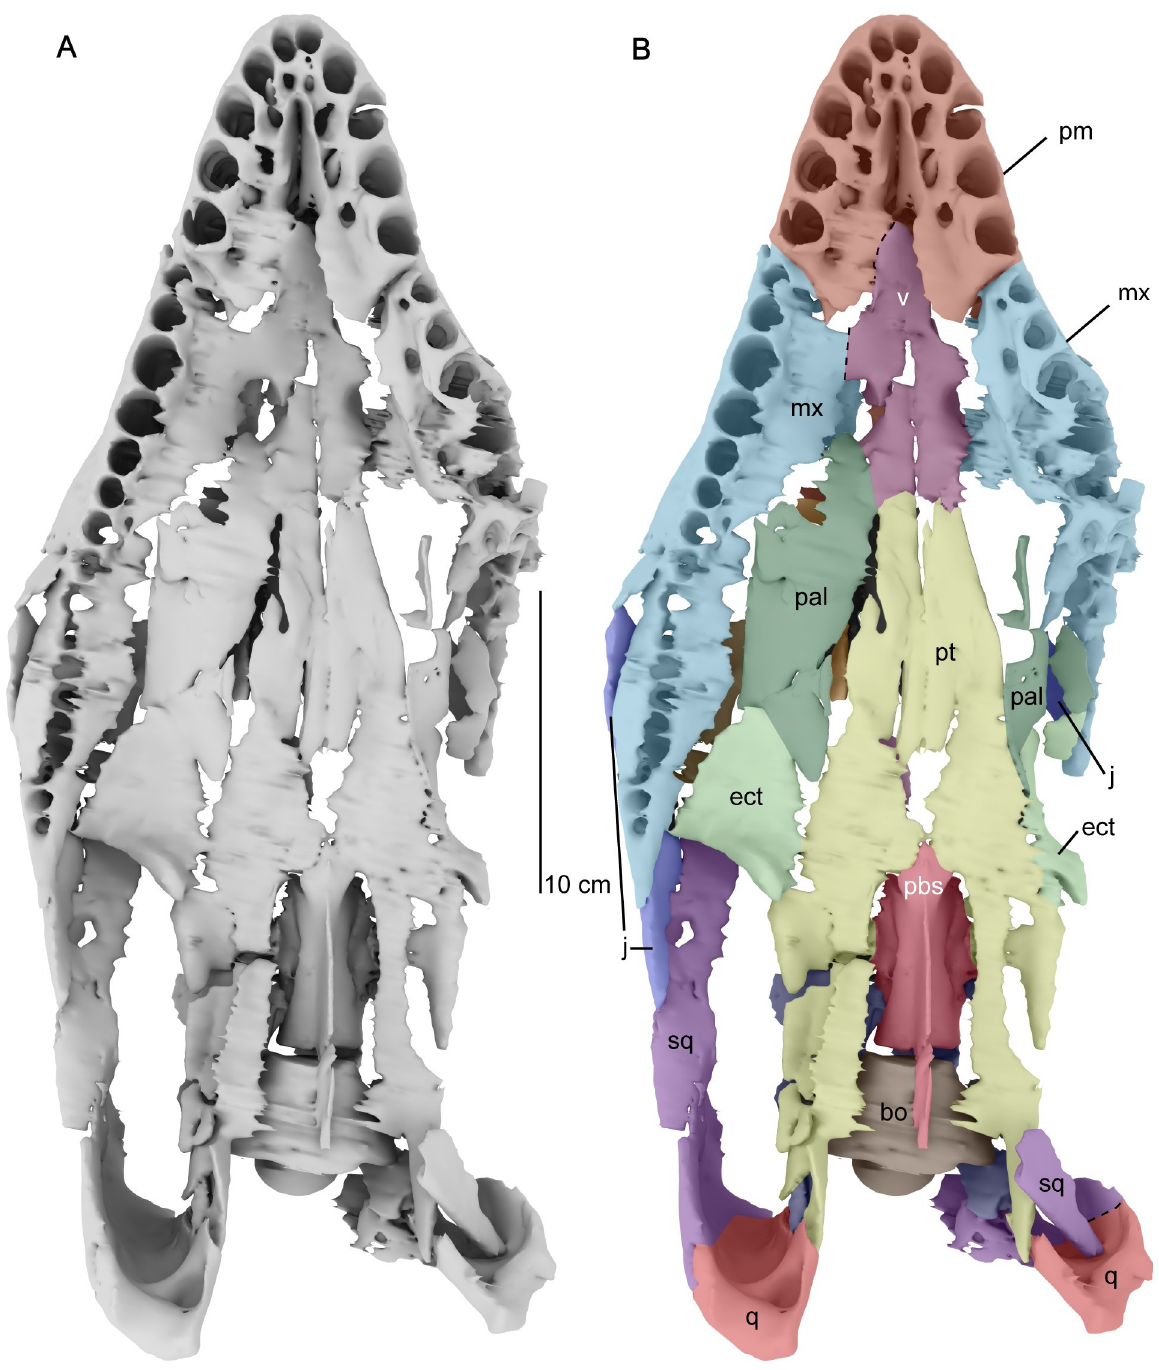
Fig 6. Three-dimensional digital model of the cranium of Cardiocorax mukulu (MGUAN PA278) in ventral view. A. uninterpreted surface model. B. separate cranial elements labeled. Dashed lines indicate approximate sutural contacts.